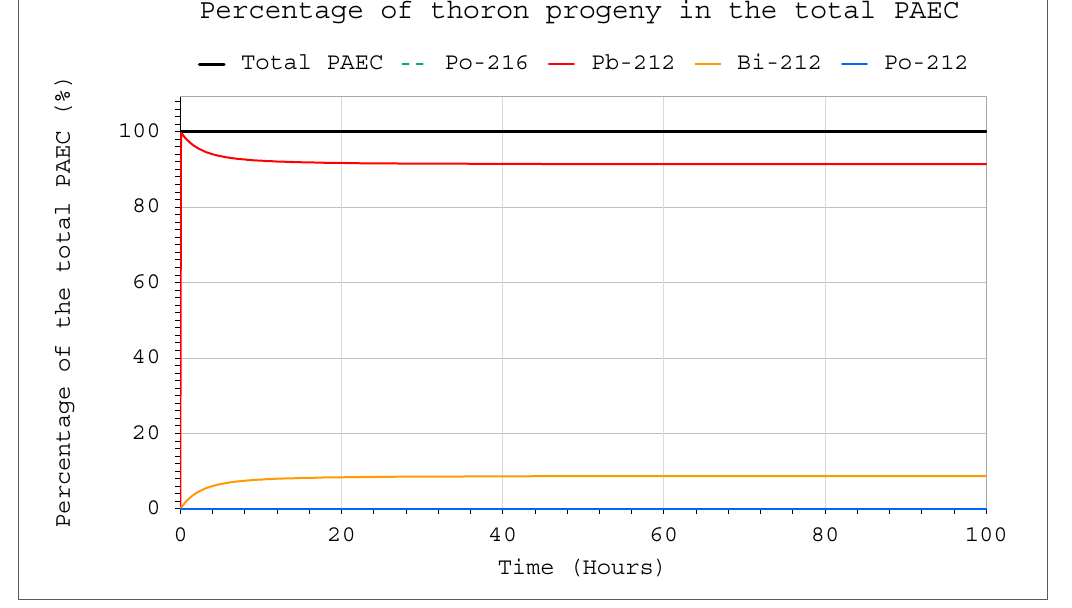
Figure 9. Activity concentration of thoron and its progeny inside the system for the following con- ditions: inflow of thoron throughout the analyzed period at a rate of E 1 = 1 Bq/s, V = 20 m 3 , C oi = 0. The filtration system was operating in the range of 40–60 h with a flow rate of Q D = 10 L/min and a filtration efficiency of F = 100%.